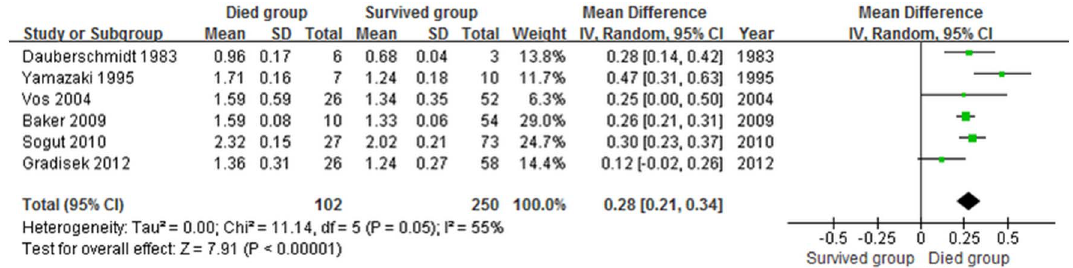
Figure 3. Association between NSE (shown as mean (SD) in transformed concentration) and mortality in patients with traumatic brain injury.